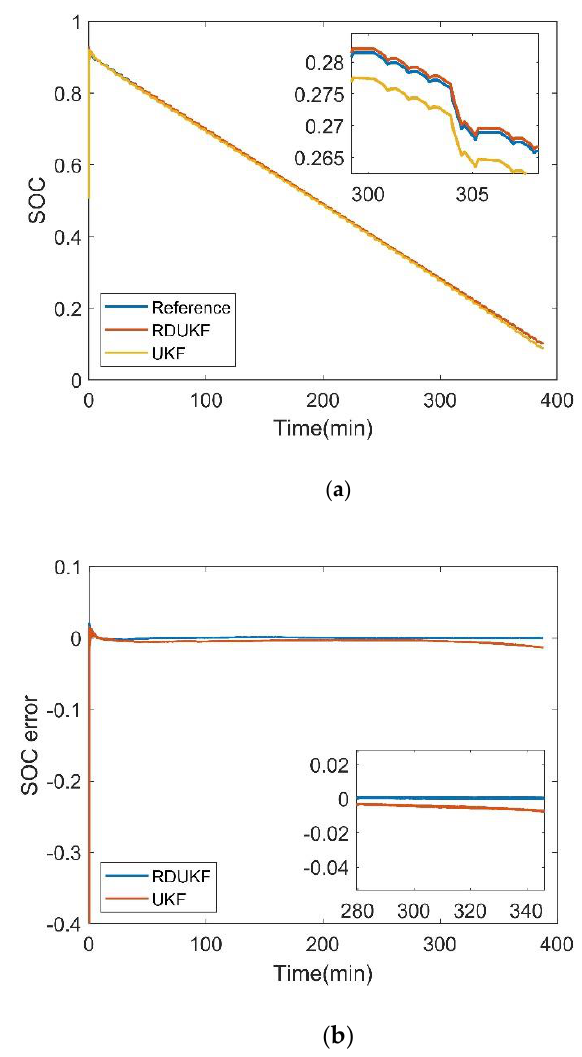
Figure 3. ( a ) SOC of the estimation results; ( b ) SOC errors of the estimation results.